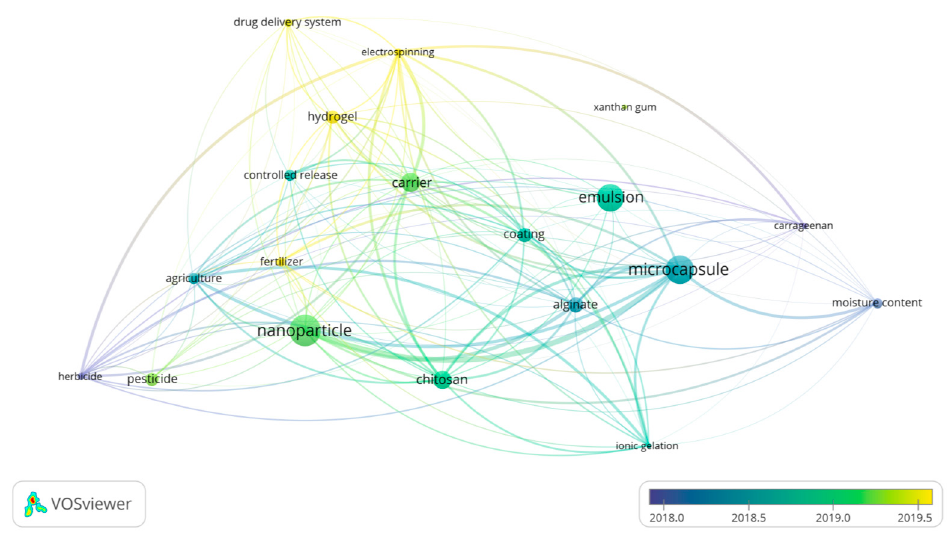
Figure 10. Map of terms of the publications on encapsulation in agriculture. The keywords “agri- culture” and “encapsulation” were searched in the titles, abstracts, and keywords, during the period from 2010 to 2020. The analysis is based on all the publications that are classified as Articles. The distance between terms indicates how strong their relationship is. The color represents the age of the term, in the period between 2018 and 2020, where blue is closest to 2018, and yellow is close to 2020. The size indicates the number of publications in which the term appears. References were taken from WoS and